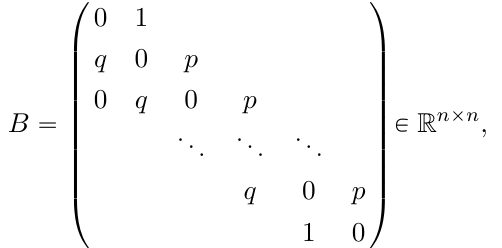
Table 2. Numerical results for Example 3.